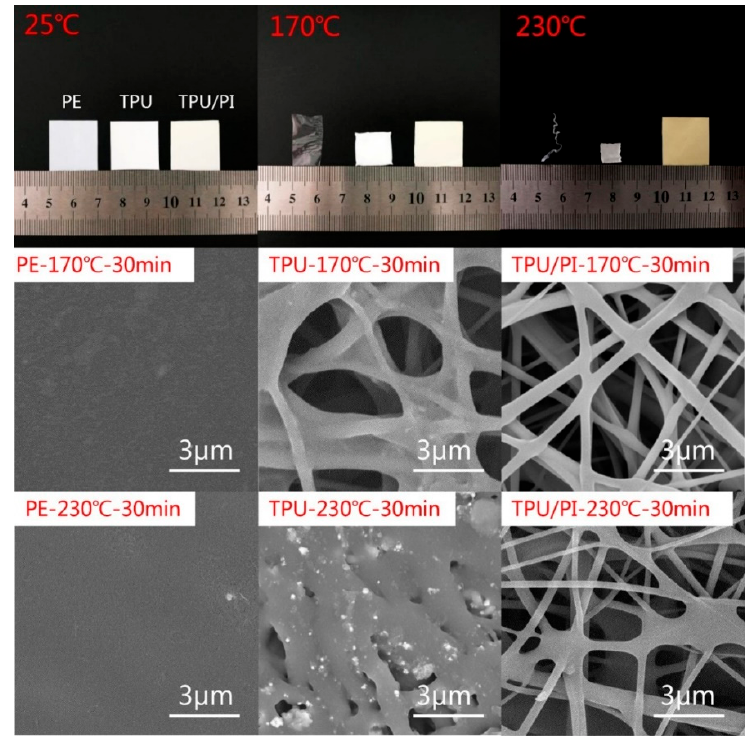
Figure 4. The photograph and SEM of PE, TPU and TPU/PI before and after heat treatment at 170 °C and 230 °C for 30 min.